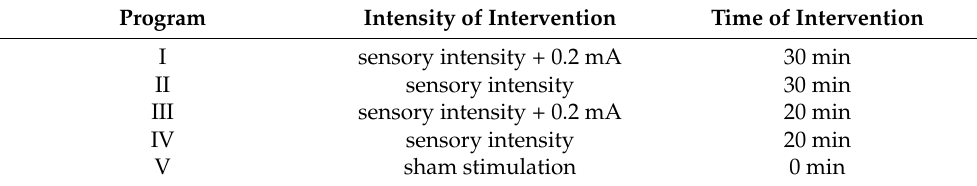
Table 2. Intervention programs of